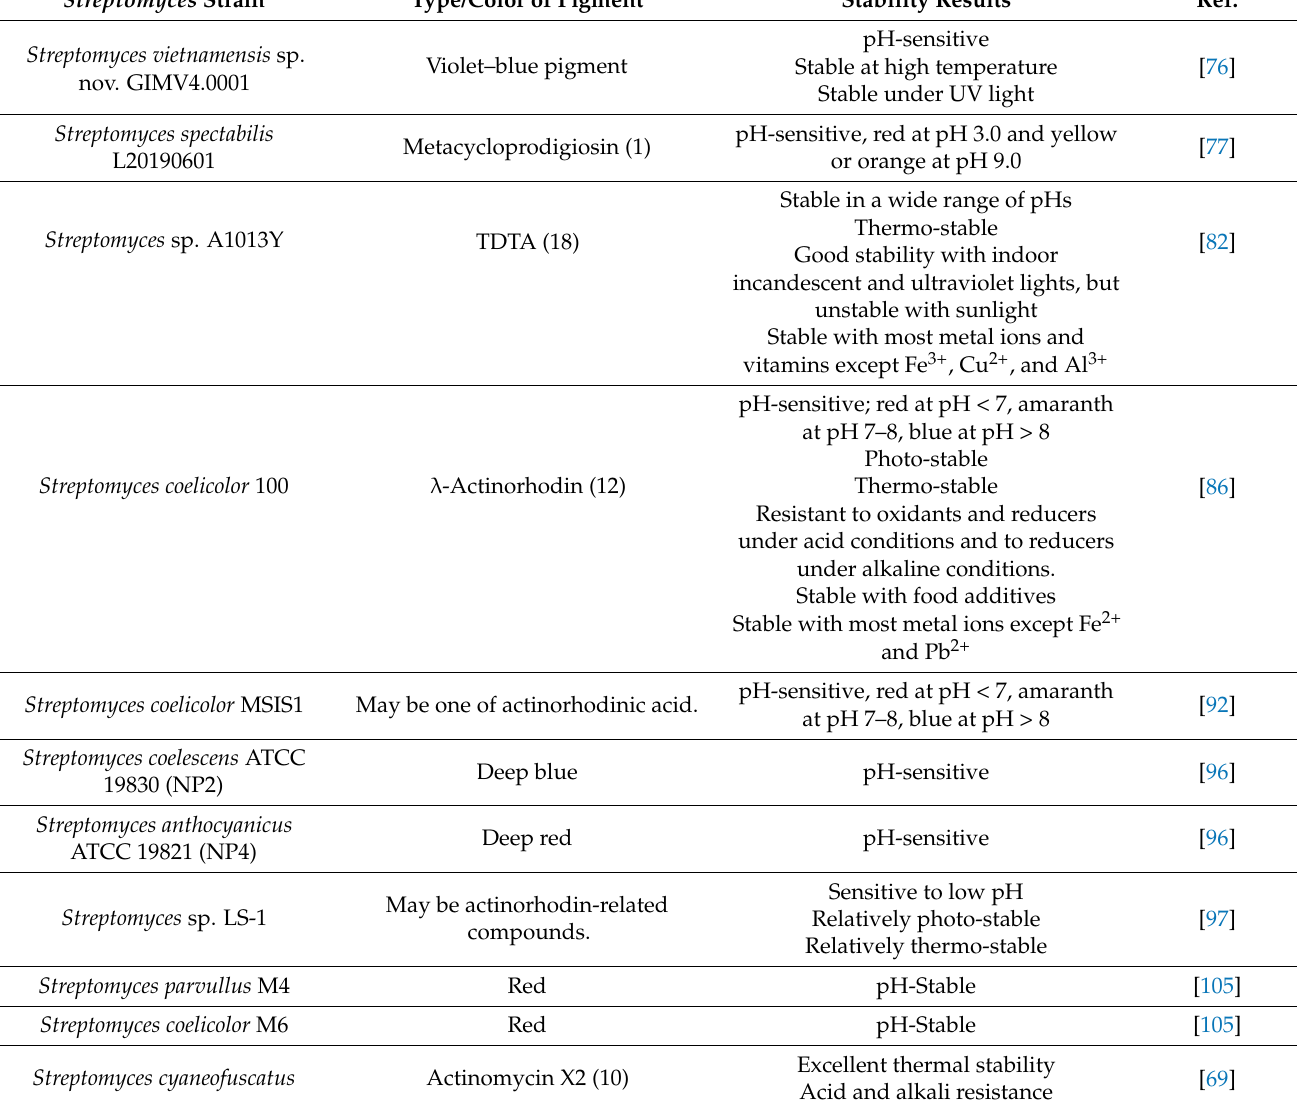
Table 3. Stability reported for each type of pigment and the Streptomyces strain that produces it.